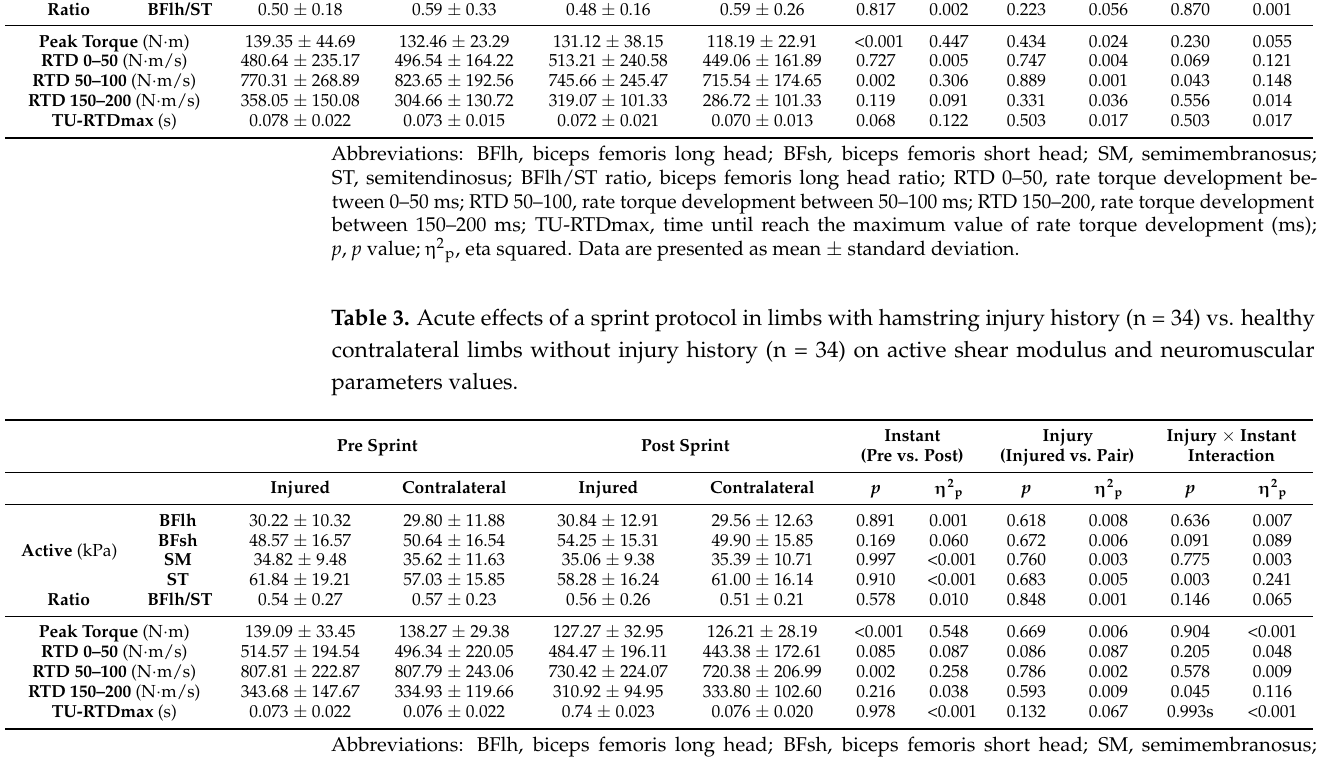
Table 2. Acute effects of a sprint protocol in limbs with previous biceps femoris long head injury history (n = 14) vs. healthy control limbs (n = 14, individuals with the same age without any hamstring injury in the same side limb) on the active shear modulus and neuromuscular parameters values. Pre Sprint Post Sprint Instant (Pre vs. Post) Injury (Injured vs. Pair) Injury Injured Control